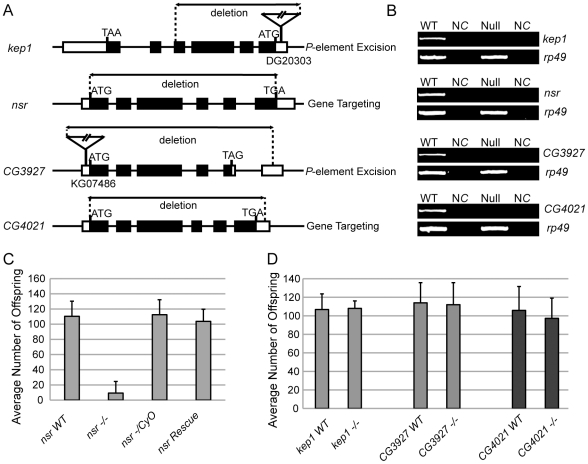
Generation of null mutants for each kep1 family gene and the male fertility test.(A) Schematic maps of mutant alleles of kep1 family genes generated by P-element excision or targeted mutagenesis. The exons (black block), start codon (ATG), stop codon (TAA/TGA/TAG), and deleted genomic regions are indicated. For kep1 and CG4021, the P-element insertion for further excision is shown by a triangle, with a Bloomington stock number given underneath. (B) RT-PCR examination of null mutants (Null) for each kep1 family gene relative to WT flies (WT). Negative control (NC) is the reaction without reverse transcriptase, and the expression of rp49 is used as internal control. (C) Fertility test for nsr WT and mutant males. nsr WT: WT controls with identical genetic background with nsr mutants; nsr -/-: homozygous nsr mutants; nsr -/CyO: heterozygous nsr mutants; nsr Rescue: flies with a copy of WT nsr transgene in the nsr mutant background. Error bars indicate standard deviation. (D) Fertility test for kep1, CG3927, and CG4021 WT and mutant (-/-) males. Error bars indicate standard deviation.